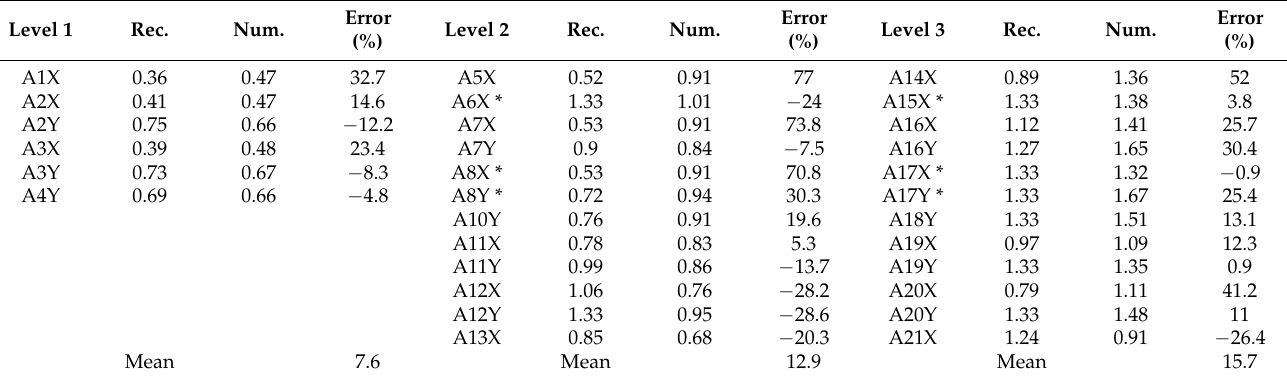
Table 4. Maximum absolute accelerations (in g) recorded (Rec.) and calculated (Num.) for the 2016 main shock. The location of the sensors is reported in Figure 4, and their names are completed with the axis direction; sensors located in collapsed portions are evidenced with an asterisk. The sensors are grouped with respect to the corresponding elevation (Level 1, 2 and